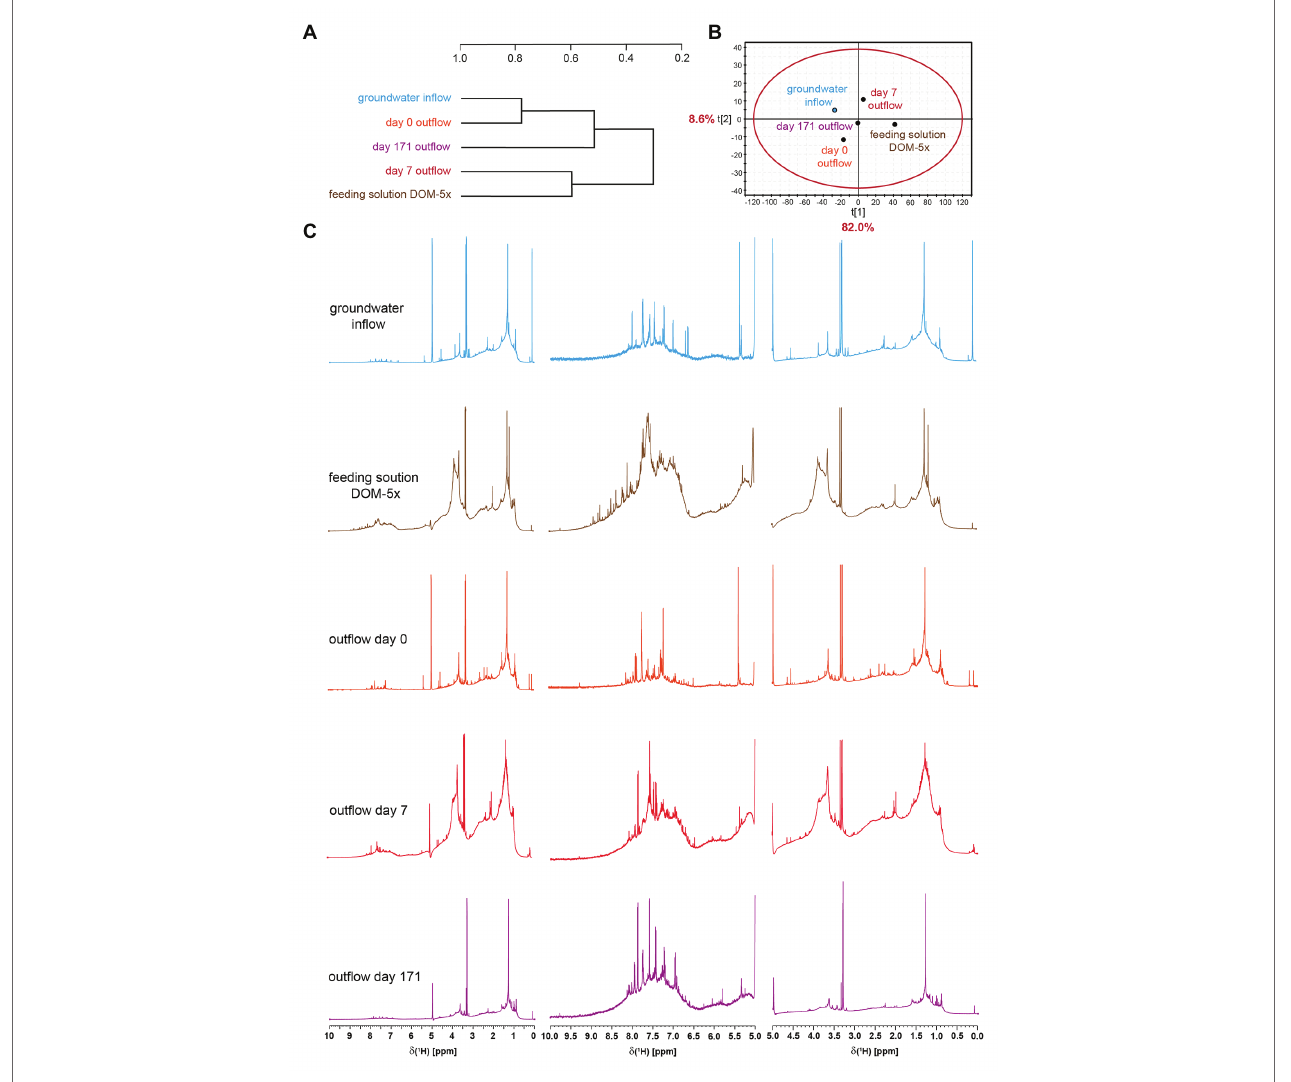
FIGURE 3 | Hierarchical cluster analysis (A) and principal component analysis (B) derived from 1 H NMR spectra (800 MHz, CD 3 OD) of porewater solid phase extracts (SPE)-DOM from DOM-5x (C) supplied sediments. HCA and PCA were computed with NMR section integrals of 0.01 ppm bucket width, with exclusion of HDO and HD 2